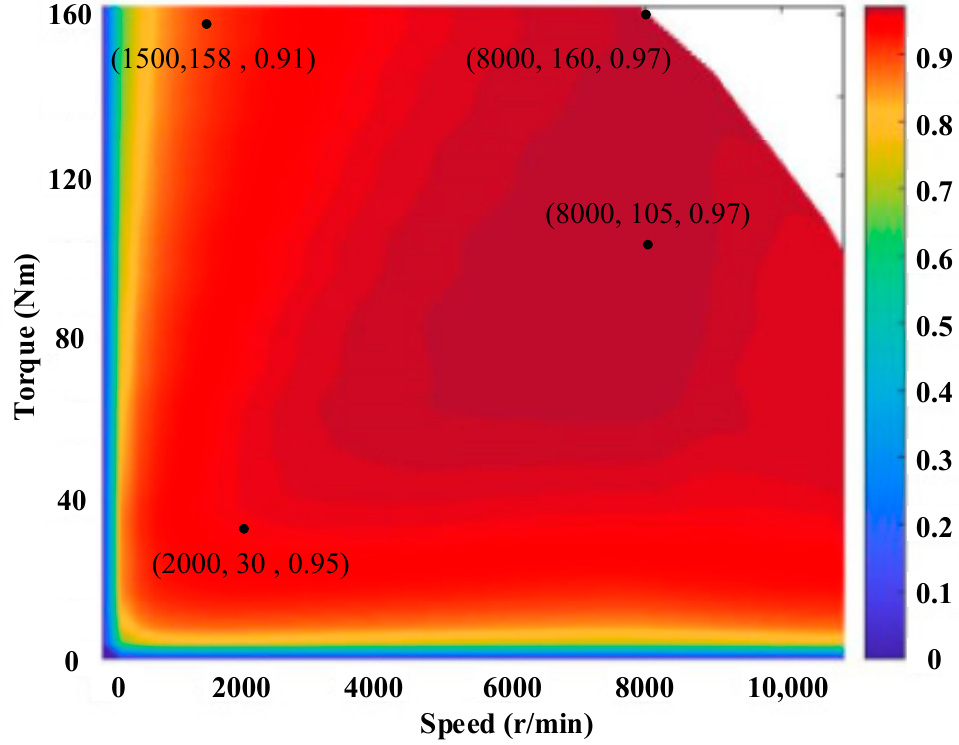
Figure 5. The e ffi ciency map of the WFSM.